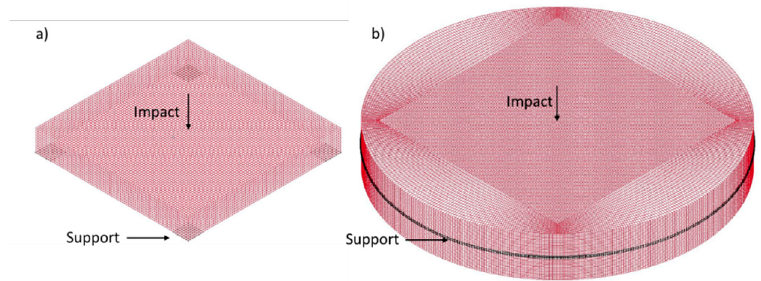
Figure 2. Isometric view of Finite Element Models ( a ) model of 50 cm × 50 cm × 7 cm plate for validation; ( b ) model of infinitely large slab for layout testing.